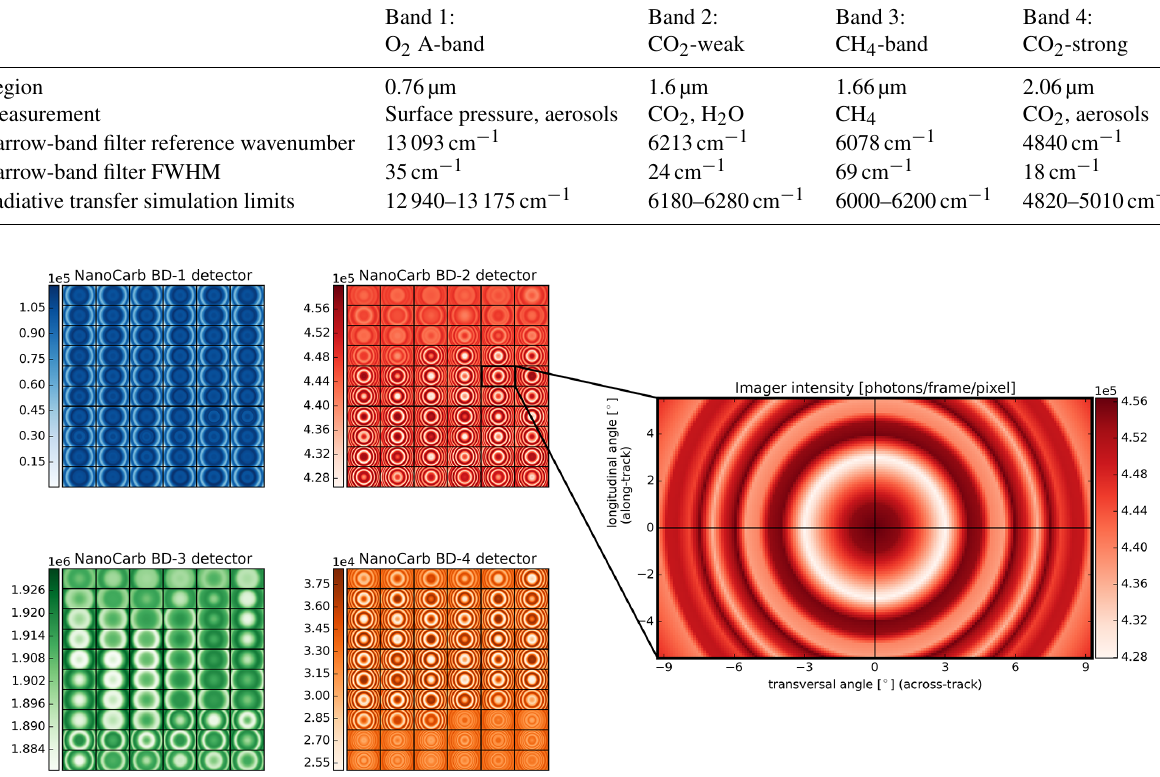
tion of the Fabry–Pérot transmission (Gousset et al.,